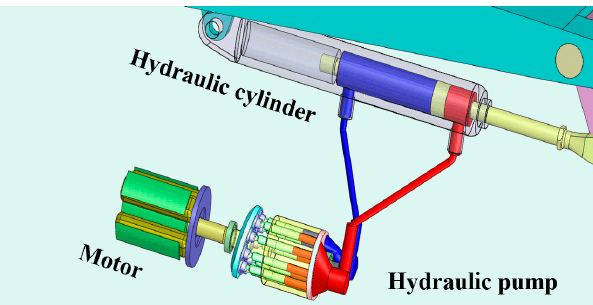
Figure 4. Schematic structure of electro-hydrostatic actuator.